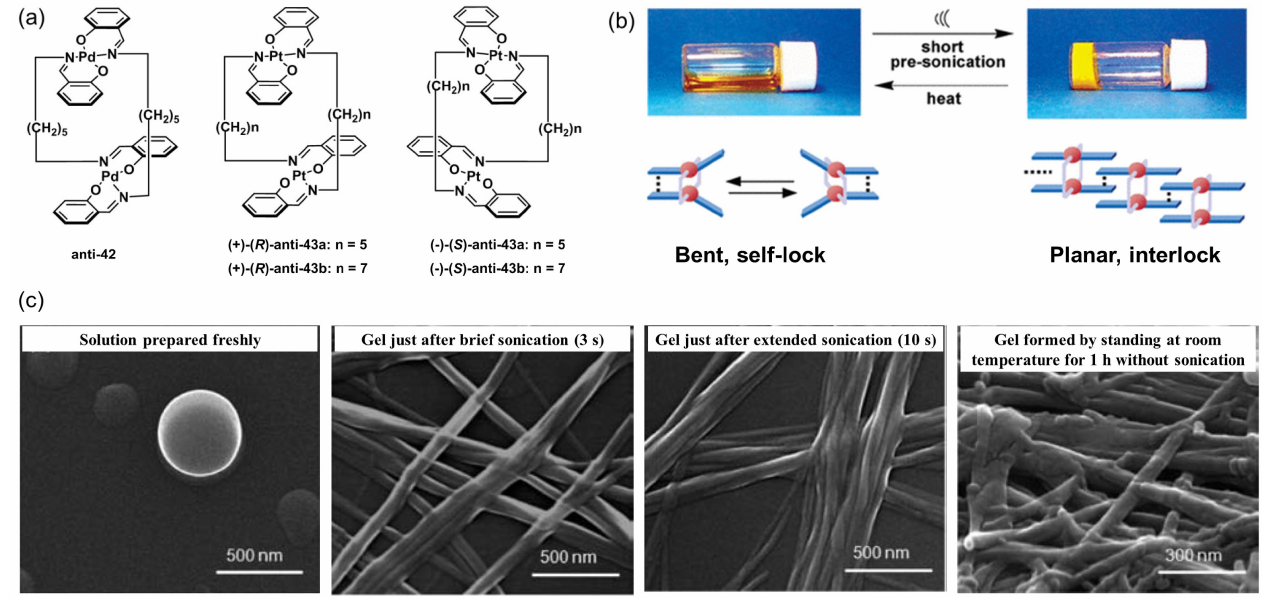
Figure 18. ( a ) Pd- and Pt-Salicylidene complexes 42 and 43 evaluated in sonication-induced gelation. ( b ) Ultrasound-induced gelation of 42 with schematic molecular packing. ( c ) SEM images of dried (()-anti- 43a aggregates prepared from a 1.50 × 10 − 3 M solution in cyclohexane using various methods. Reprinted with permission from Refs. [81,82]. Copyright (2005, 2011), American Chemical